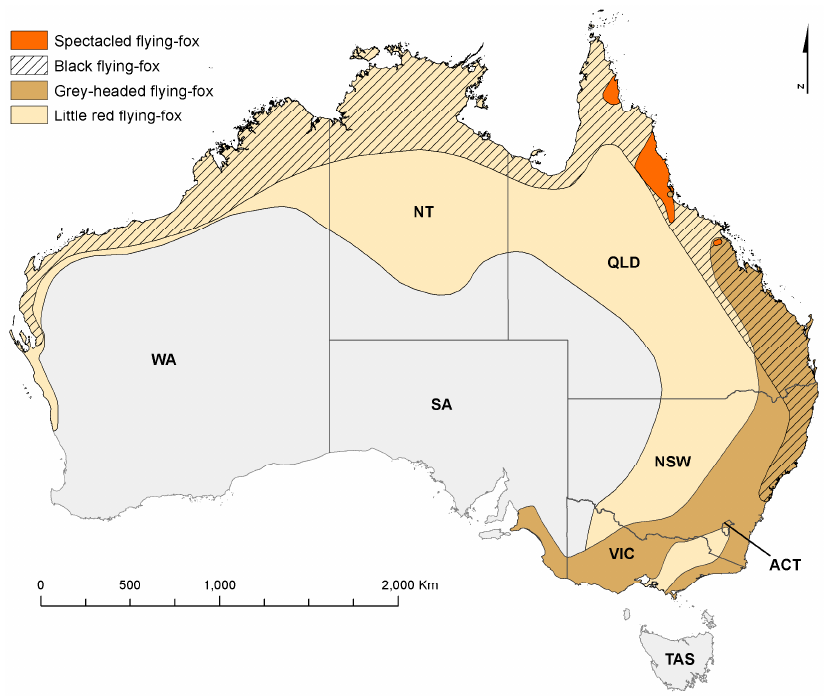
Figure 1. Distribution of Australia’s four mainland flying-fox species.